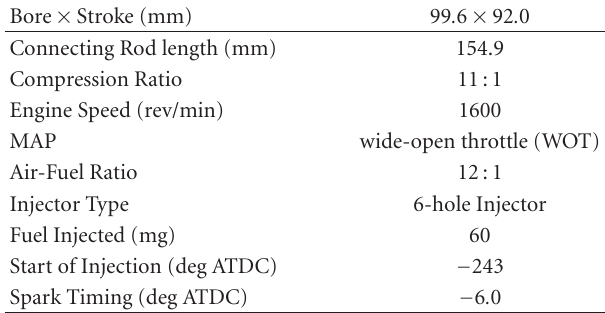
Table 1: Engine specifications and selected operating